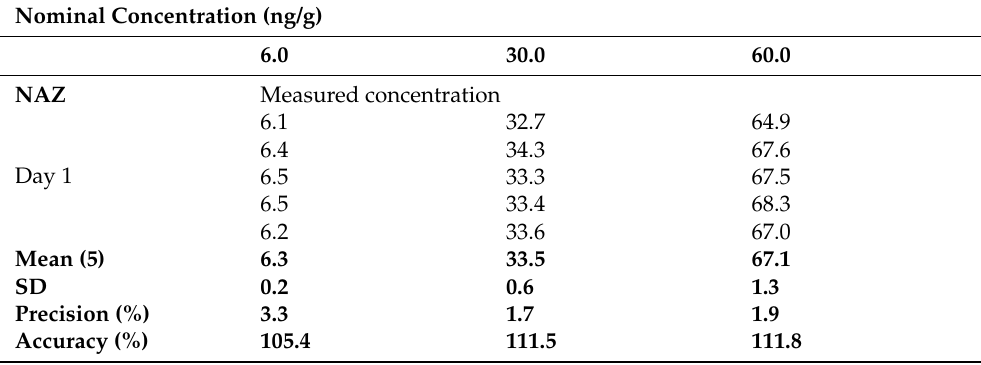
Table 5. Intraday precision and accuracy for NAZ in brain